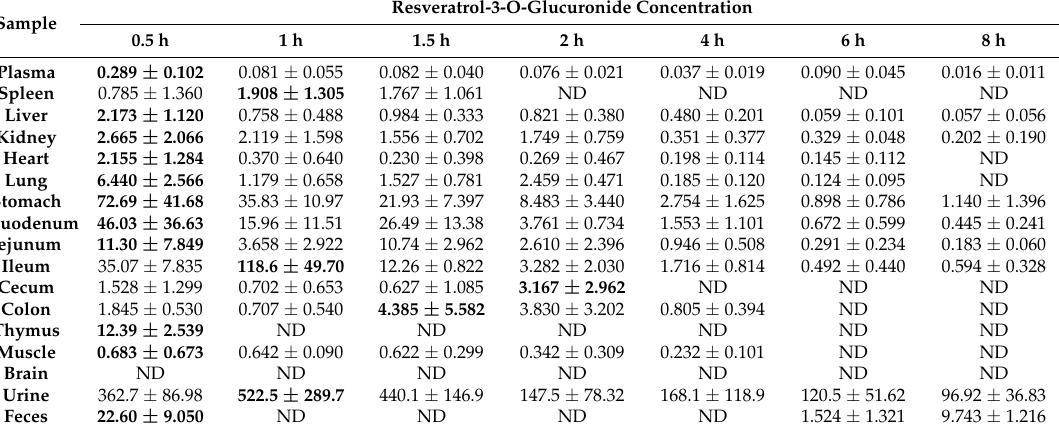
Table 2. Distribution of resveratrol-3-O-glucuronide in plasma (nmol/mL), various organs (nmol/g of tissue), urine (nmol/mL), and feces (nmol/g wet content) in mice at different time-points following the intragastric administration of resveratrol at a single dose of 10 mg/kg. Maximum concentrations (C max values) are in bold.